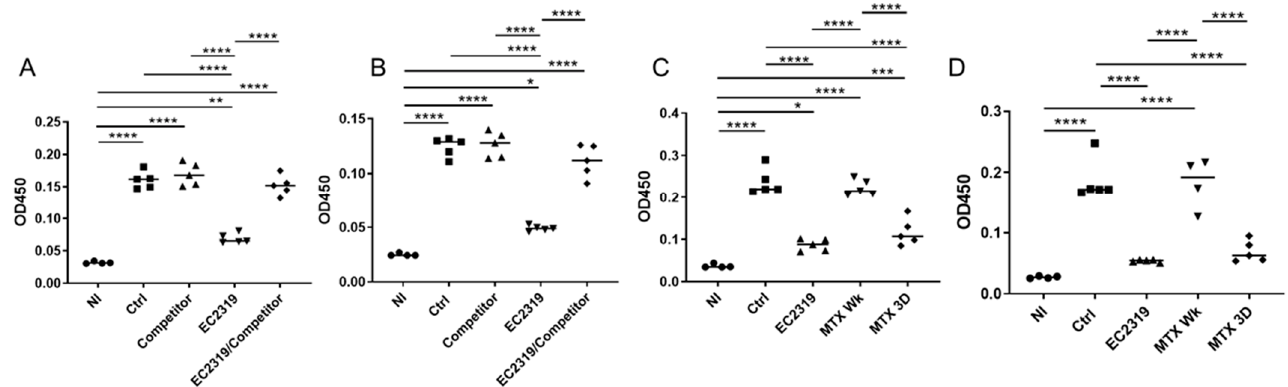
Figure 9. Systemic antigen-specific humoral immune response is attenuated by EC2319 and MTX: ( A – D ) circulating titers of total rat anti-rabbit IgG at serum dilution of 1:20 ( A , C ) and 1:100 ( B , D ) are decreased by EC2319 and MTX Wk but not by MTX 3D. The reduction in anti-rabbit IgG levels by EC2319 is prevented in rats treated with EC2319 plus FA competitor ( A , B ). * p < 0.05, ** p < 0.01, *** p < 0.001, **** p < 0.0001. For A and B: Normal, Control, Competitor, EC2319, ♦ EC2319/Competitor. For C and D: Normal, Control, EC2319, MTX Wk, ♦ MTX3D.